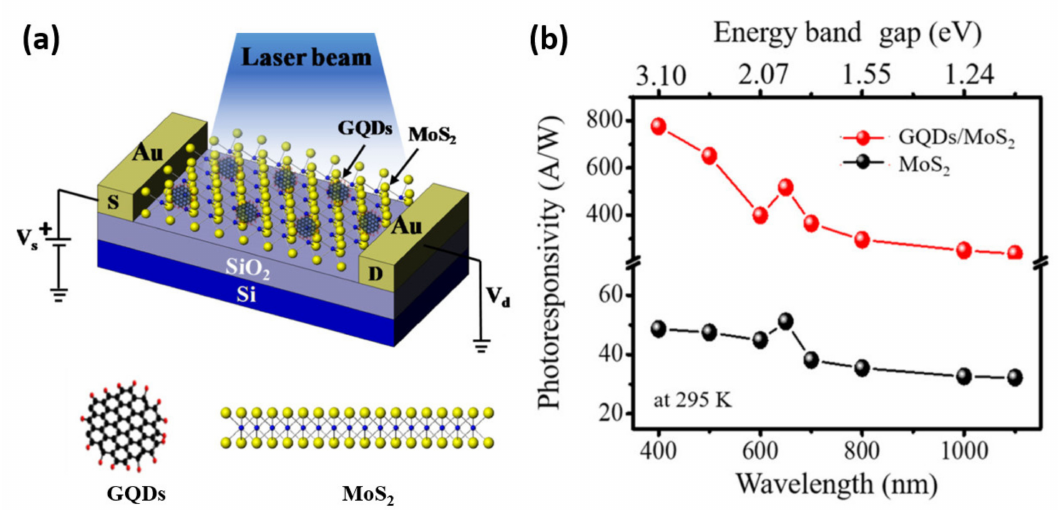
Figure 14. ( a ) Schematic of the hybrid GQD/MoS 2 device under optical illumination. ( b ) Photoresponsivity of hybrid GQD/MoS 2 and the bare MoS 2 devices. [146] Figure reproduced with permission from ACS